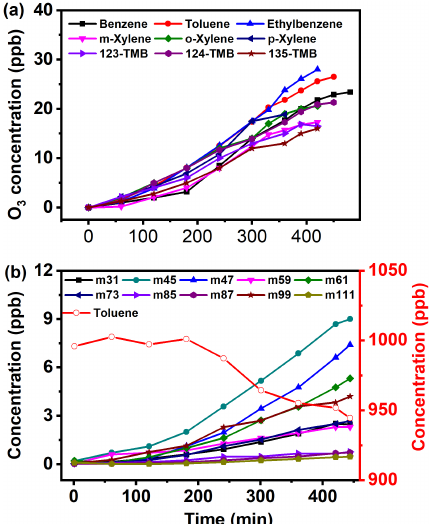
Figure 1. (a) O 3 formation curve from AH photochemical oxida- tion (2110ppb of benzene, 996ppb of toluene, 1060ppb of ethyl- benzene, 889ppb of m -xylene, 1160ppb of o -xylene, 1040ppb of p -xylene, 824ppb of 123-TMB, 935ppb of 124-TMB, 913ppb of 135-TMB) without NO x . (b) The concentration variation of inter- mediates formed from 996ppb of toluene photochemical oxidation without NO x